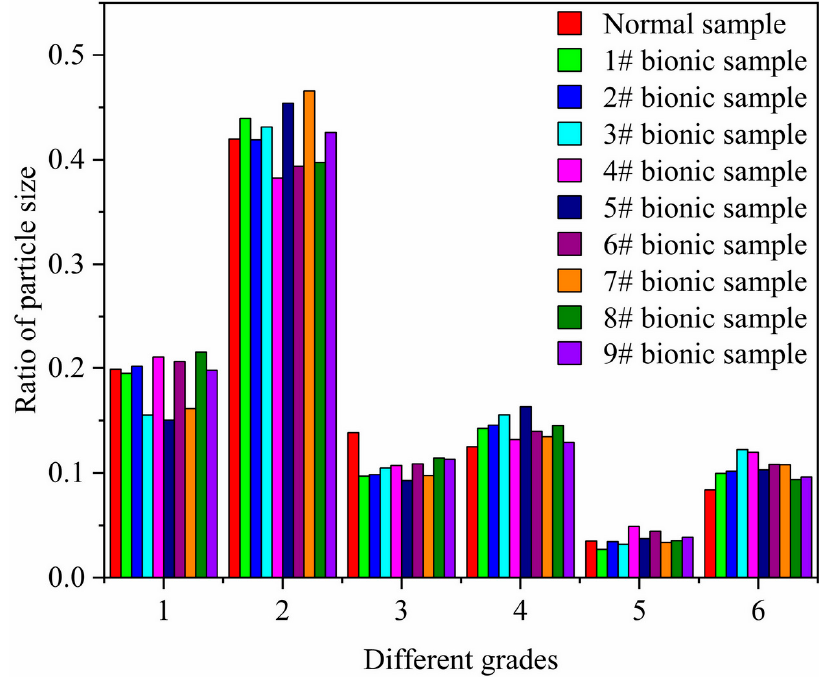
Figure 7. The effect of different grinding rollers on crushing sand.